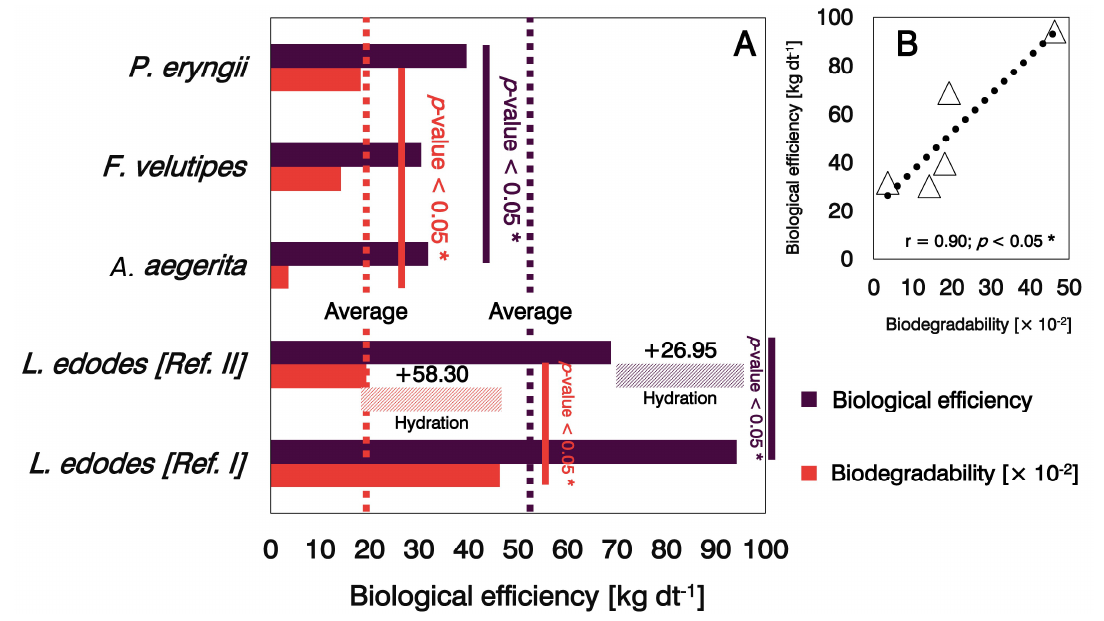
Figure 1. Biodegradability and biological efficiency of exotic mushrooms relative to L. edodes with (Ref. I) and without (Ref. II) hydration as a supplementary level of management ( A ). The functional relationship between the ability of mushrooms ( L. edodes , A. aegerita , F. velutipes , and P. eryngii ) to transform ma(cid:308)er into health-promoting, nutrient-dense biomass ( B ). The larger the bar, either of biodegradability or biological efficiency, the greater the ability of the fungus to transform lignocellulosic substrate into a mass of edible mushrooms. Significance: * p -value < 0.05. Comparatively, P. eryngii (Km = 0.2; BE = 39.6 kg dt −1 ) converted more substrate into